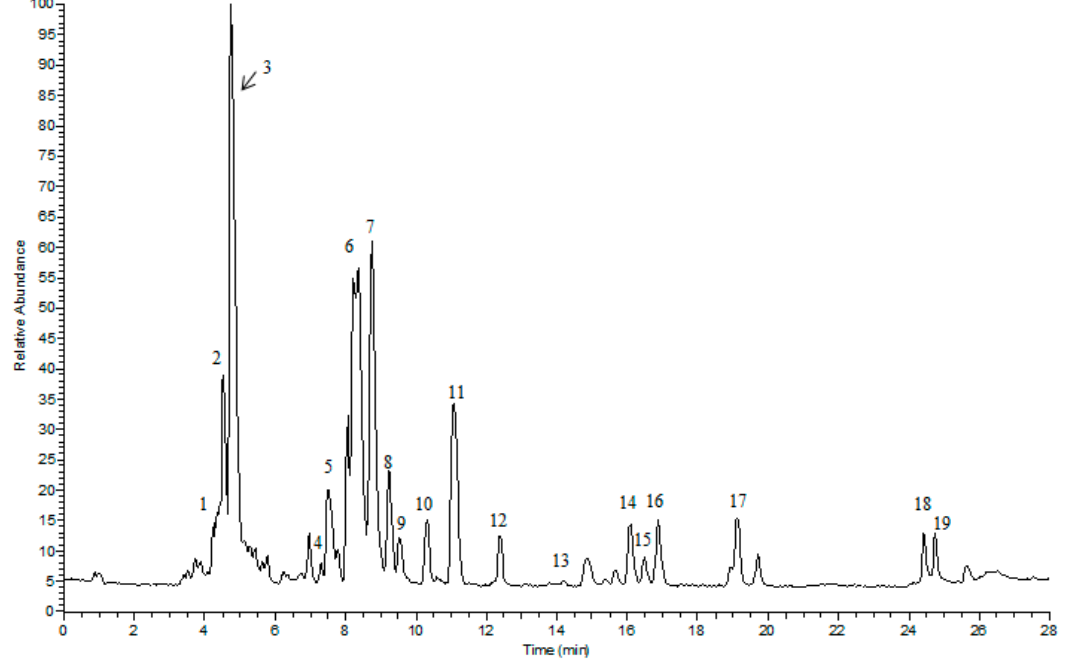
Figure 1. The representative total ion current chromatogram of PNS in negative ESI modes. The corresponding compound names were given in Table 1 (varying from no. 1 to 19). Table 1. All the identified or tentatively identified components of PNS and their UPLC-MS/MS data.